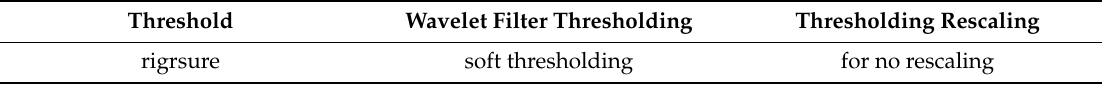
Table 2. Wavelet filtration settings for CO 2 signal